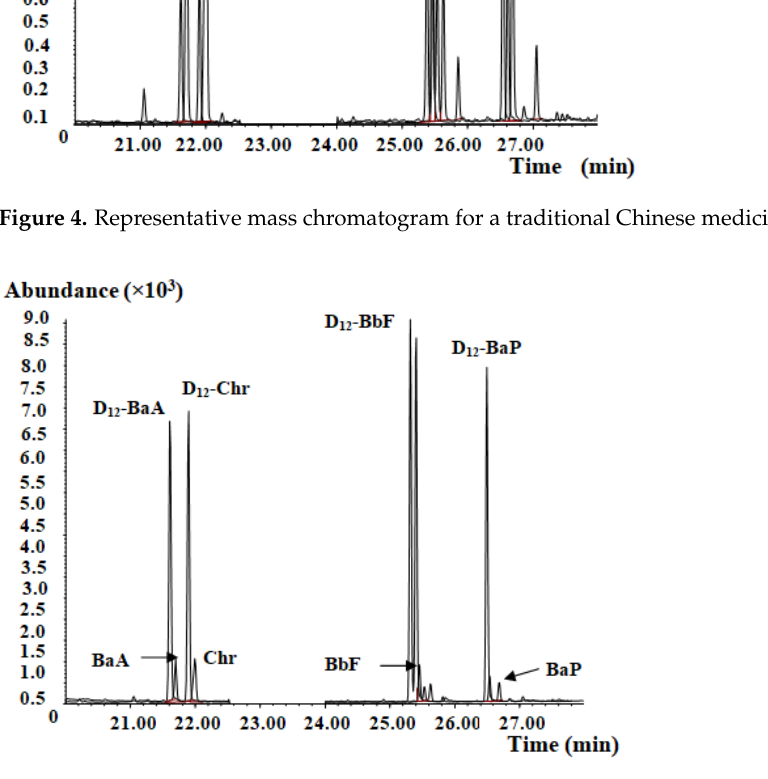
Figure 5. Representative mass chromatogram of CMRM-containing health food. Table 4. Results of PAH4 in Rhodiola Rosea L. extract and spirulina.